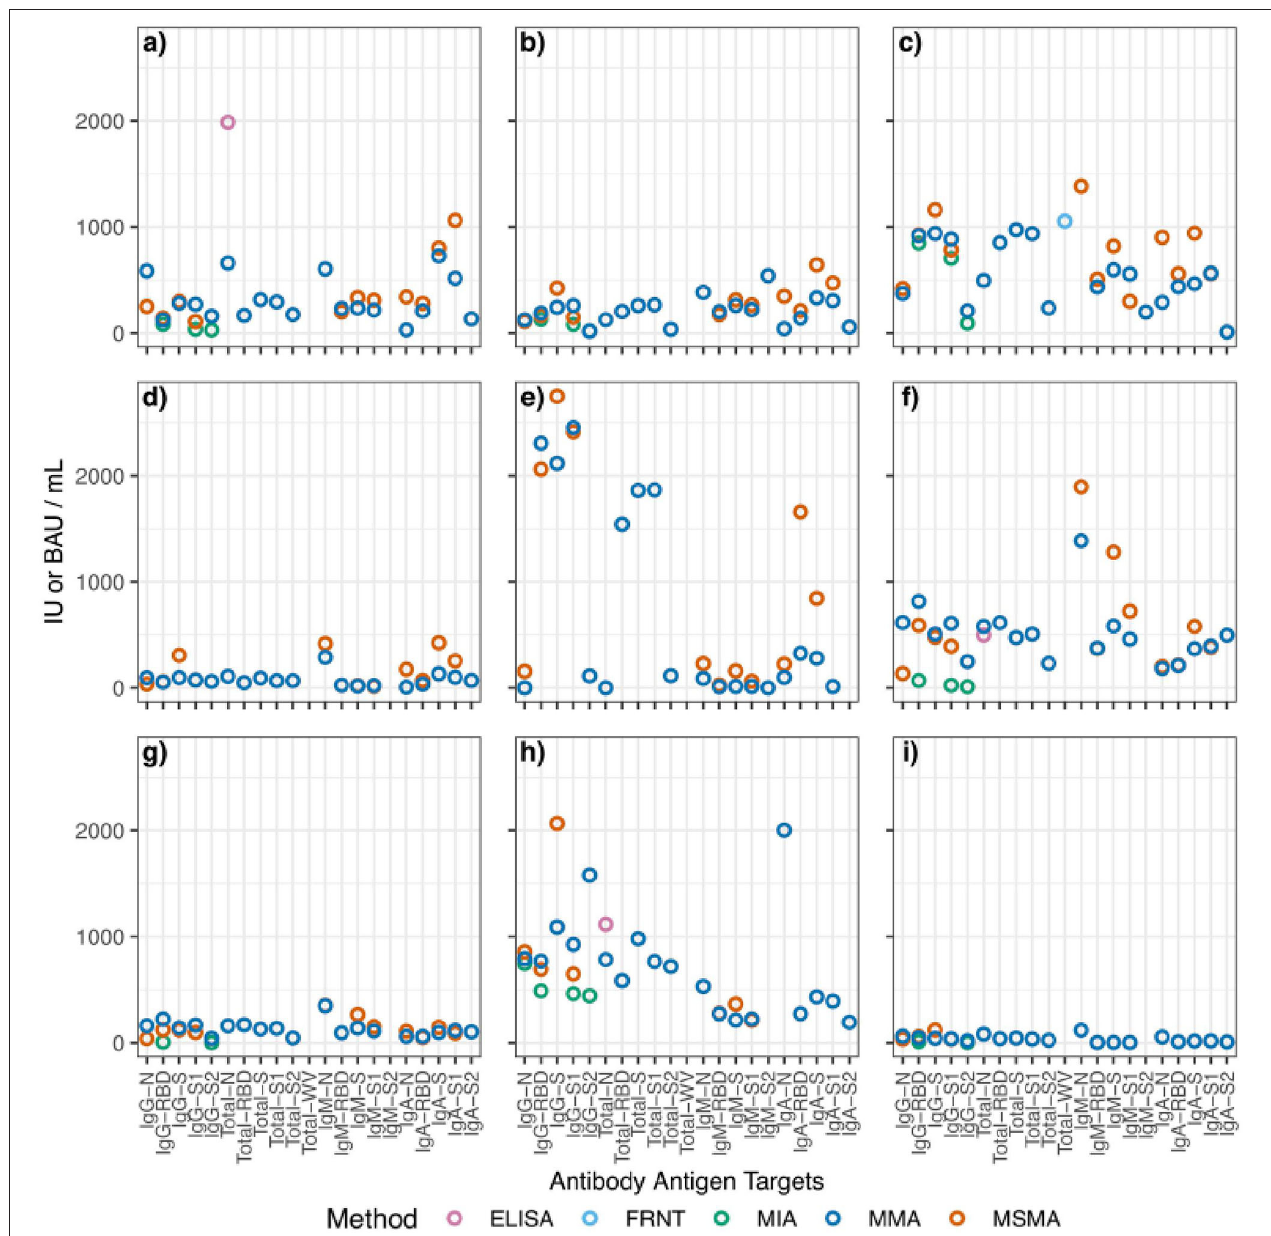
FIGURE 1 | Aggregated scatterplot of computed binding antibody unit conversions for each reference sample. The following samples are represented by each subfigure: (a) 1WA-A; (b) 1WA-B; (c) 1WA-C; (d) 416029; (e) 416048; (f) CSCP-HR; (g) CSCP-WR; (h) NCI Frederick; (i) ThermoFisher. MIA, multiplexed microsphere immunoarray; MMA, multiplexed microsphere assay; Nab, neutralization; ELISA, enzyme-linked immunosorbent assay; FRNT, focus-reduction neutralization titer. The following samples were removed because they were classified as “non-reactive” during testing: 1WA-D, 416006,